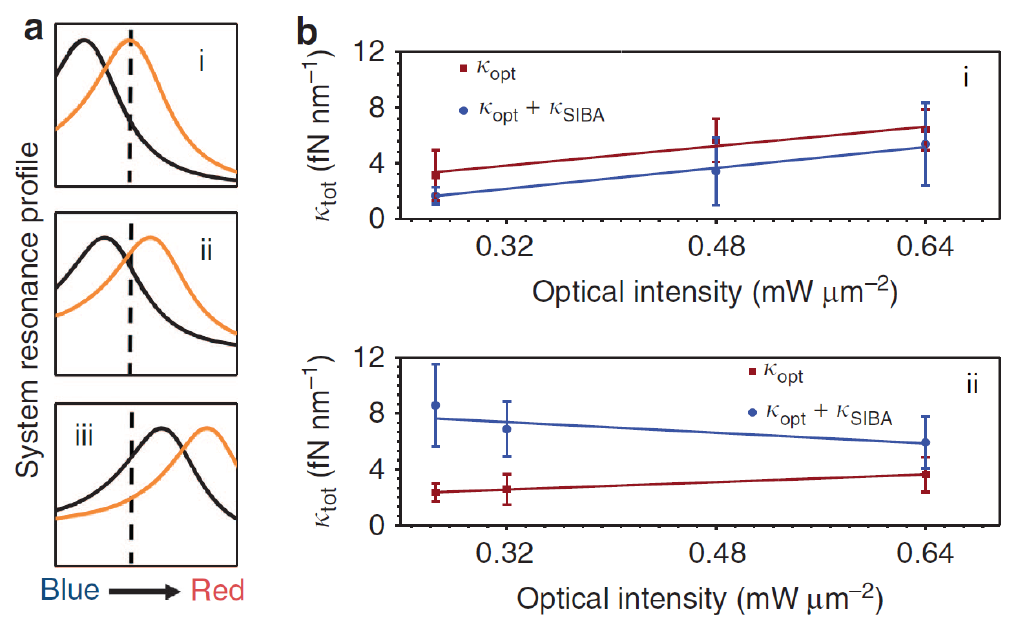
Figure 10. ( a ) Three different cases of the resonance profile of a plasmonic cavity (black line). In case (i), (ii), and (iii) the cavity is designed to be blue-detuned, slightly blue-detuned and red-detuned, respectively, from the excitation laser (vertical dashed line). The orange line represents the frequency shift of the resonance of the cavity due to the existence of the particle near by it. In case (ii), the SIBA effect has a positive influence on the trap and, whenever the particle tries to escape, the photon flux (intensity) increases, which causes, increase to the gradient force. ( b ) Experimental measurements of the total trapping stiffness as a function of the incident laser intensity. ( b )(i) corresponds to case ( a )(i), where as the intensity decreases both the total and the empty cavity trapping stiffness decrease, making the trap inefficient. ( b )(ii) corresponds to case ( a )(ii), and clearly shows that, as the laser intensity decreases, the empty cavity trapping stiffness decreases, but the total stiffness increases due to the positive contribution from the SIBA effect, thus achieving a stable, self-adjustable trap. Figures